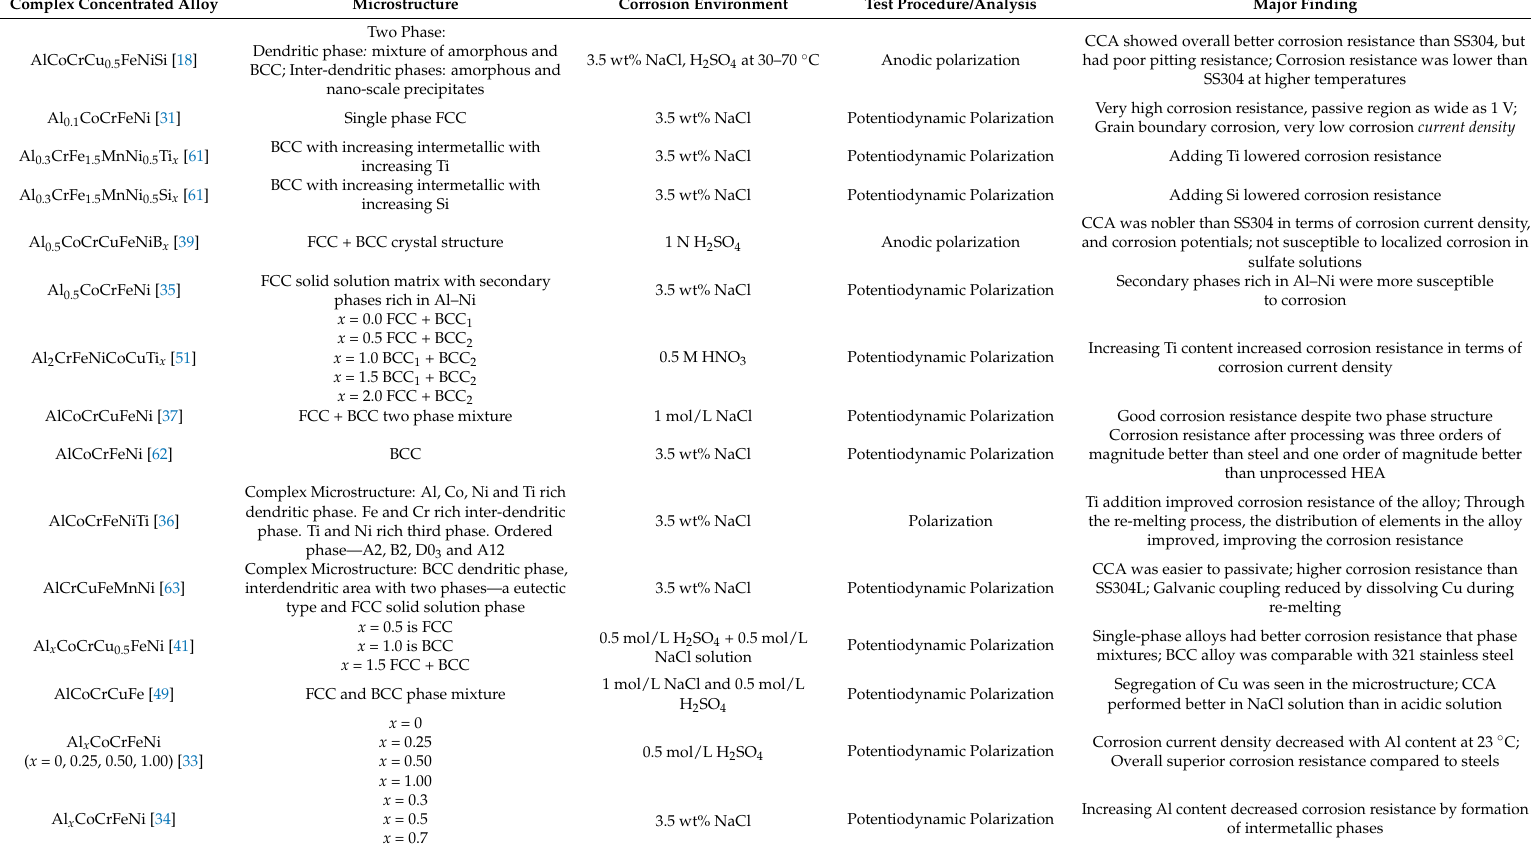
Table 2. Summary of potentiodynamic/anodic polarization tests of various complex concentrated (high entropy) alloys in aqueous, acidic, and sulfate